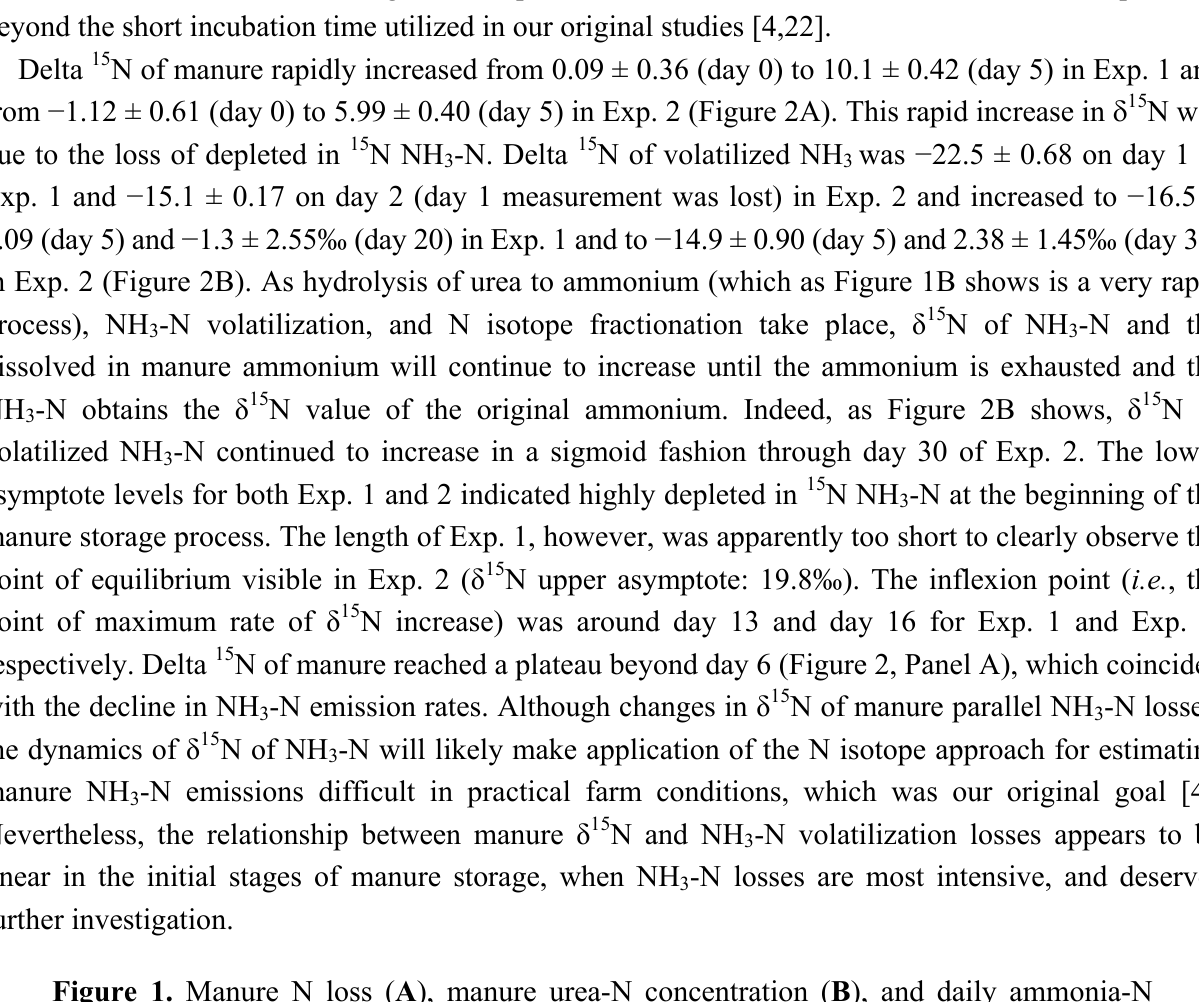
Figure 1. Manure N loss ( A ), manure urea-N concentration ( B ), and daily ammonia-N emission ( C ) in Experiments 1, 2, and 3 (means ± SE; n =